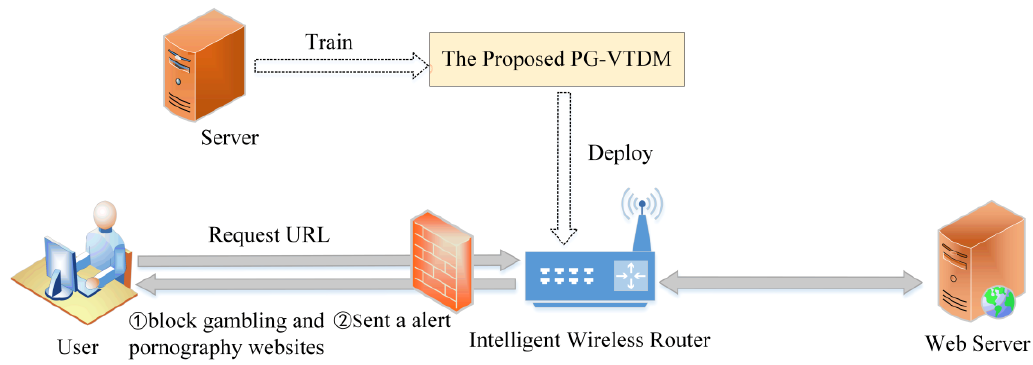
Figure 1. The working scene of the proposed system. PG-VTDM: Automatic detection system for porn and gambling websites based on visual and textual content using a decision mechanism, URL: Uniform resource locator.